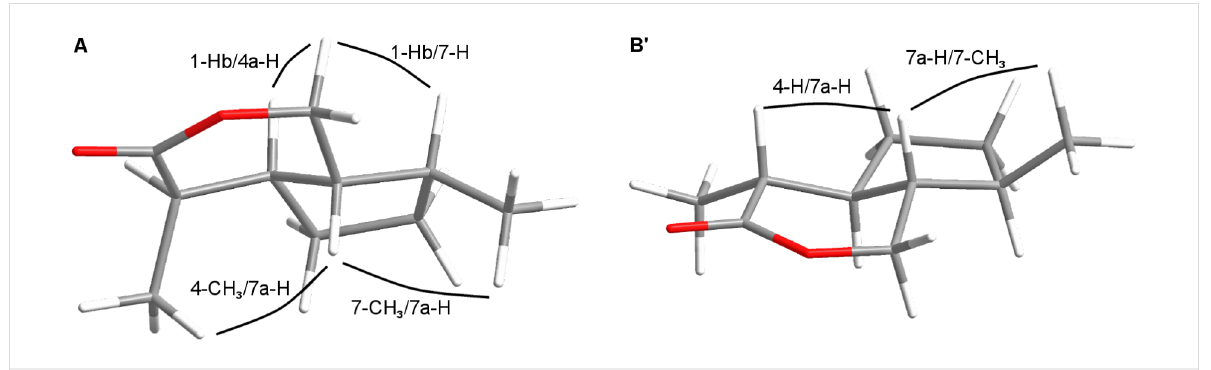
Figure 5: Configurations of the trans -fused iridomyrmecins A and B’